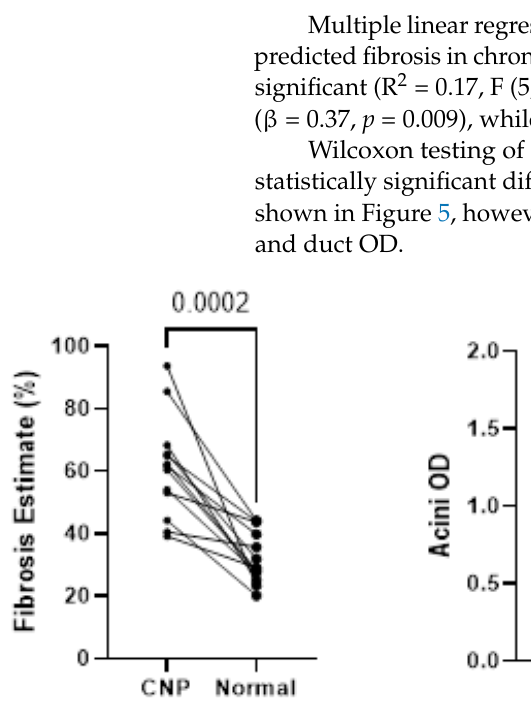
Figure 4. Linear regressions comparing cohort fibrosis, acini optical density, and ductal optical density. OD, optical density.